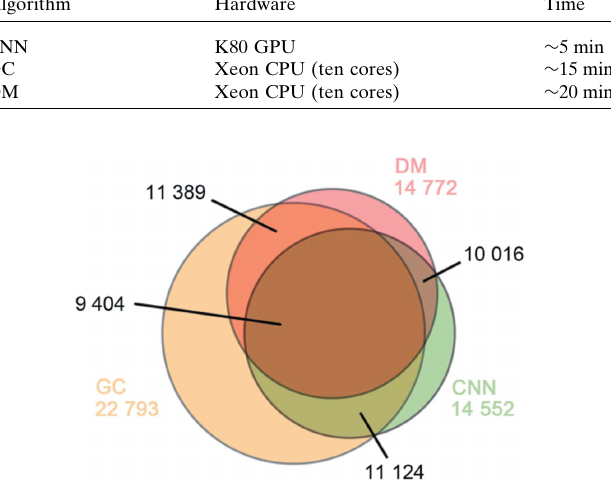
Figure 2 Venn diagram for the three sets of single-particle scattering patterns. There are 10016 commonly selected patterns between the CNN and DM, 11124 patterns between the GC and CNN, and 11389 patterns between the GC and DM. A total of 9404 patterns were tagged as single-particle scattering patterns by all three methods.